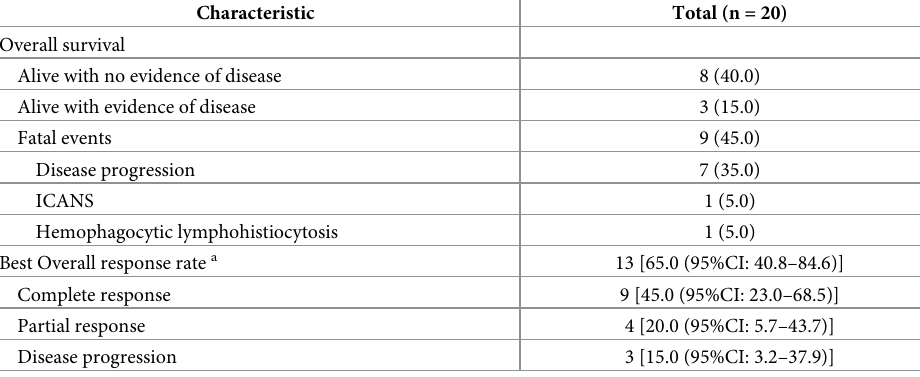
Table 2. Effectiveness